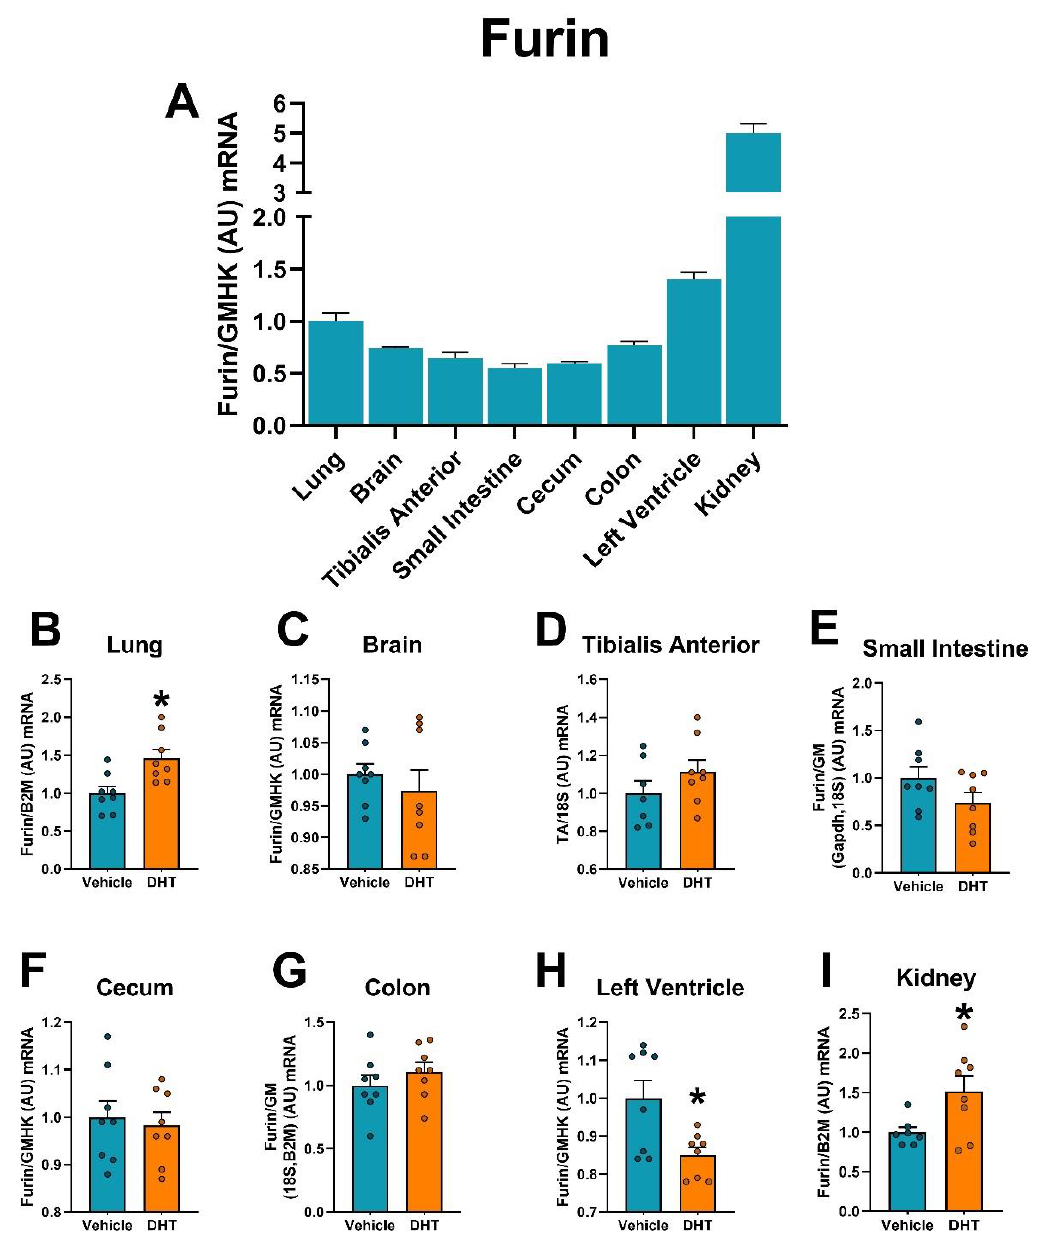
Figure 9. Furin mRNA expression regulation by DHT in different tissues. Furin mRNA expression was quantified by RT- qPCR. ( A ) Furin mRNA expression in control mice normalized to the geometric mean of all reference genes and expressed relative to lung tissue. ( B – I ) Furin mRNA expression in the lung ( B ), brain ( C ), tibialis anterior ( D ), small intestine ( E ), cecum ( F ), colon ( G ), left ventricle ( H ), and kidney ( I ) of control and DHT-treated mice normalized to the least variable reference gene or set of them and expressed relative to control mice. Data analyzed by t -test. n = 7–8/group. *: p < 0.05.